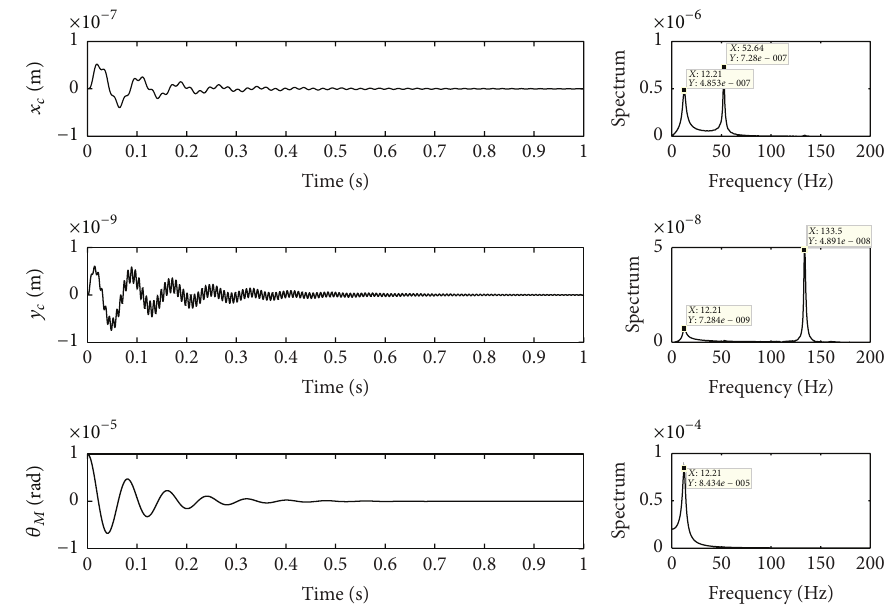
Figure 8: Dynamic response to the variation in roll rotational angle for V 𝑟 = 20 m ⋅ s −1 .